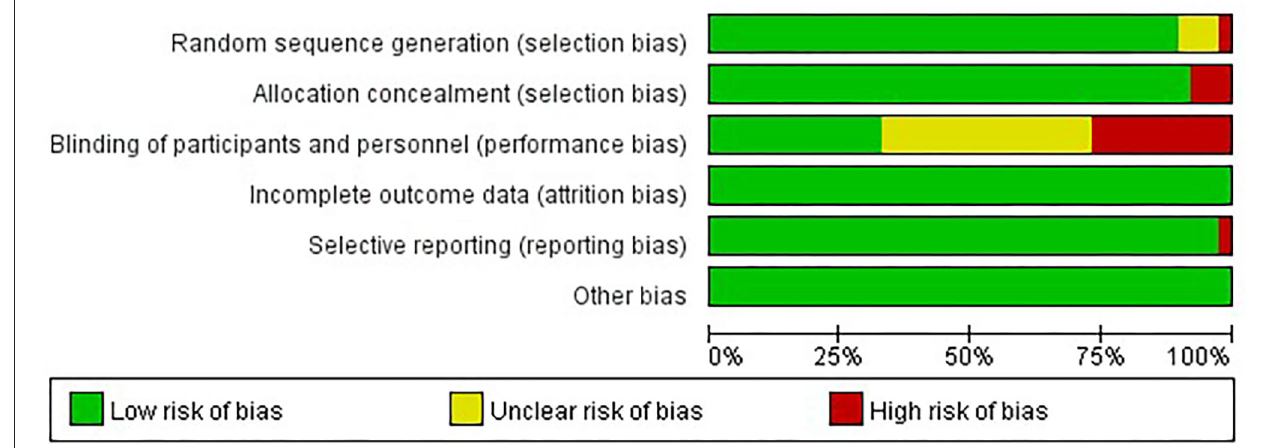
FIGURE 2 | The results of the risk of bias within